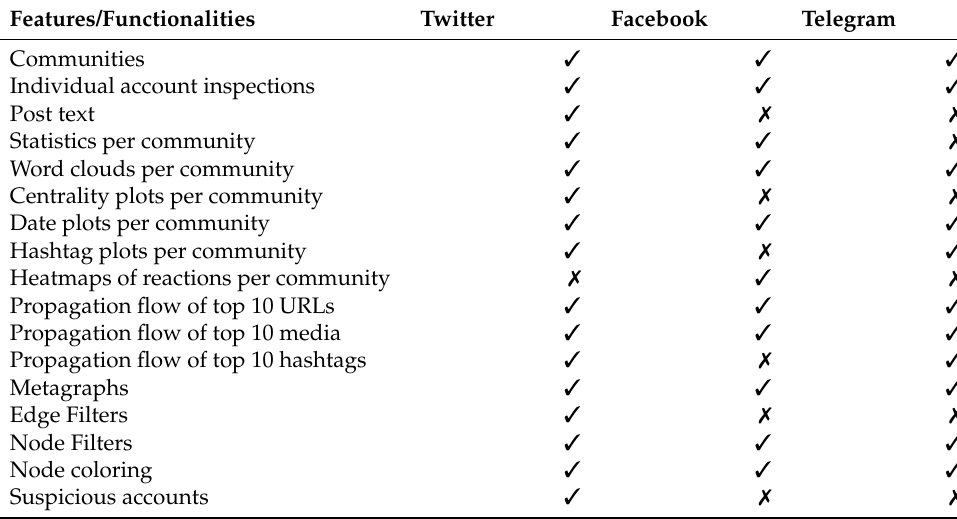
Table 4. List of developed features and the platforms that are